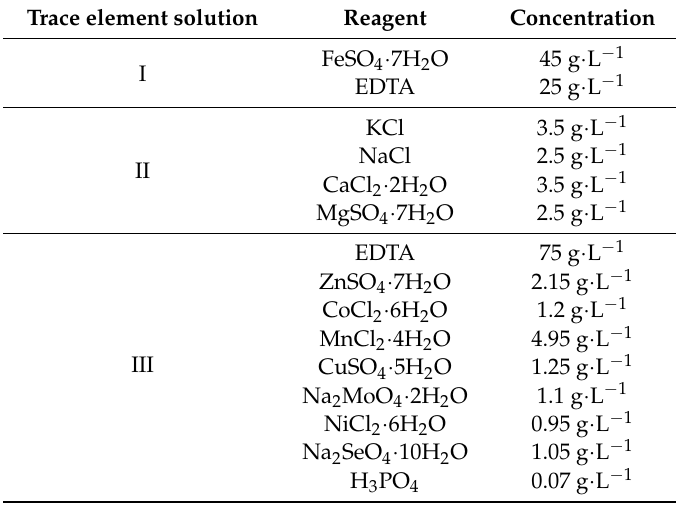
Table 1. The compositions of trace element solution I, II, and